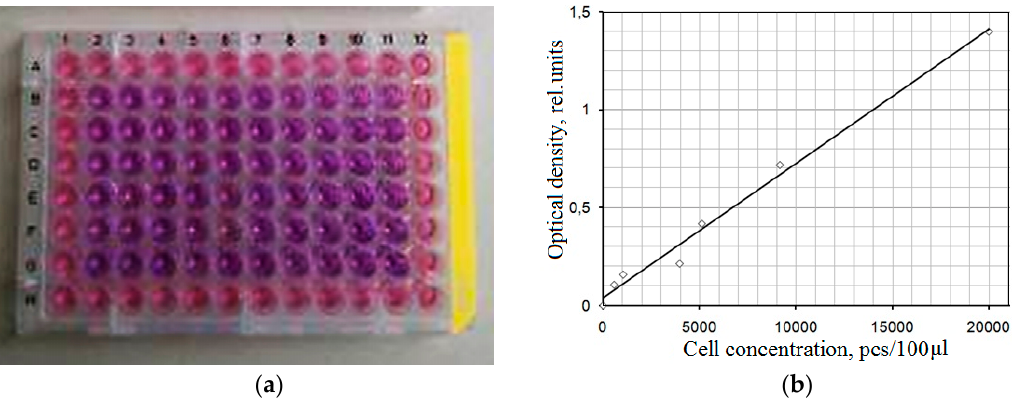
Figure 2. Photo of the culture plate before measuring the optical density ( a ); calibration graph of the dependence of the number of cells on the optical density ( b ).